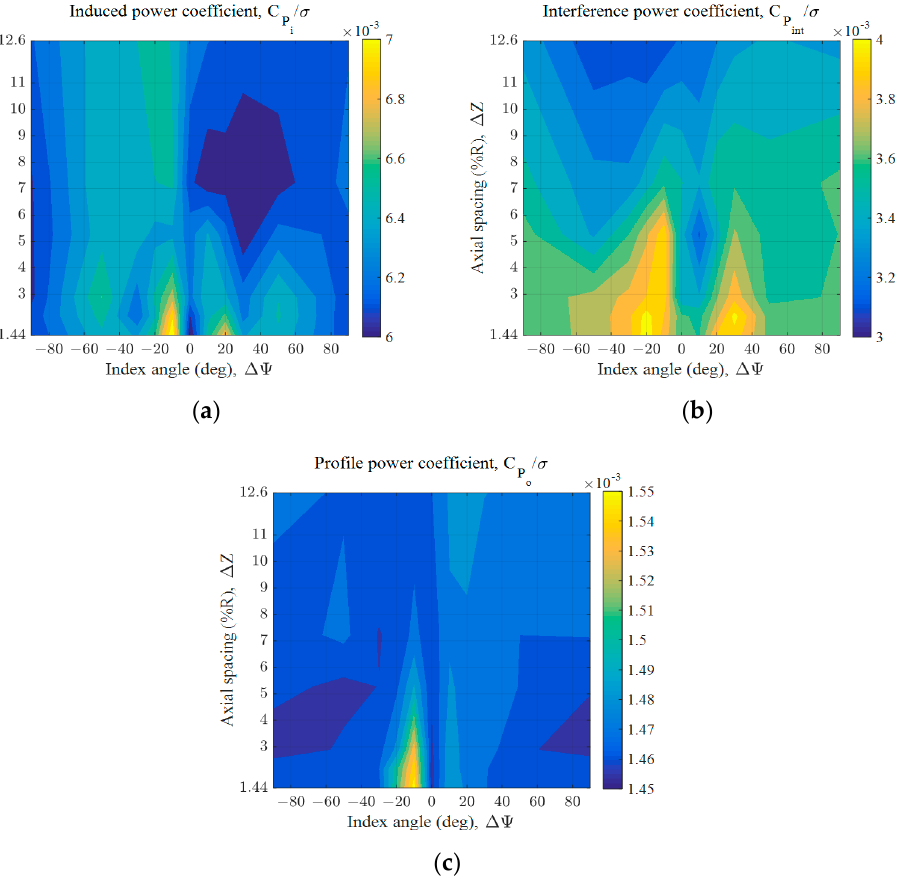
Figure 14. Rotor power components with different index angles and axial spacings ( C T = 0.0102): ( a ) Induced power ( C Pi / σ ); ( b ) interference power ( C Pint / σ ); ( c ) profile power ( C Po / σ